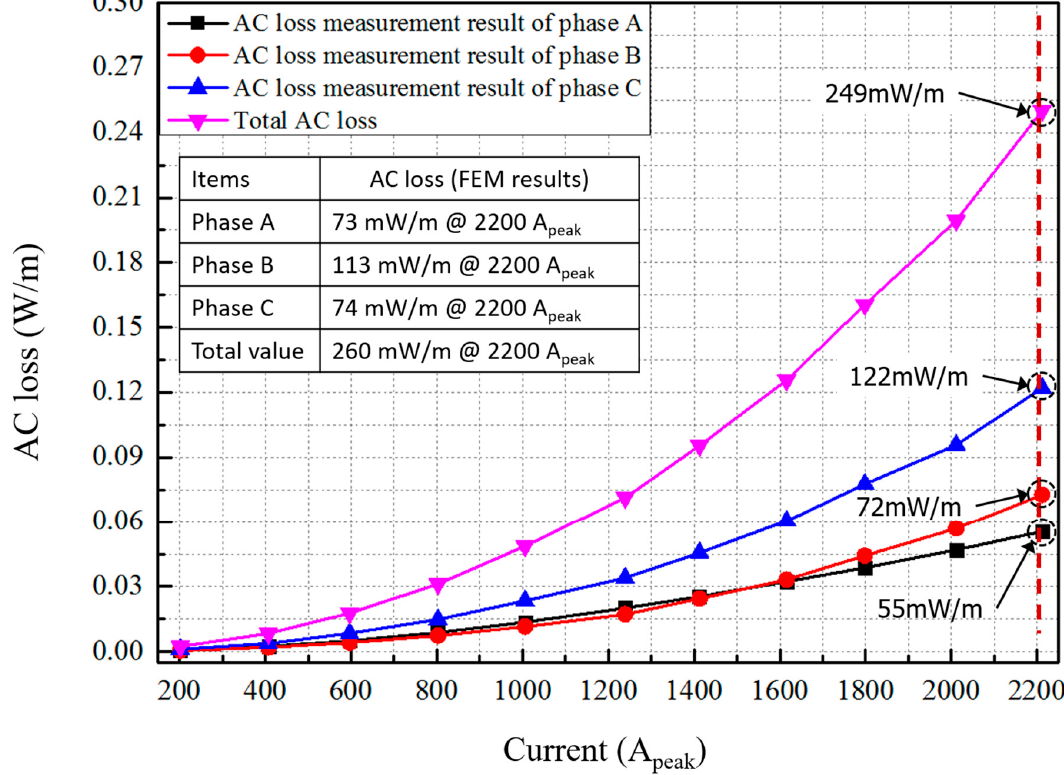
Figure 15. Measurement results for AC loss of the tri-axial HTS power cable.